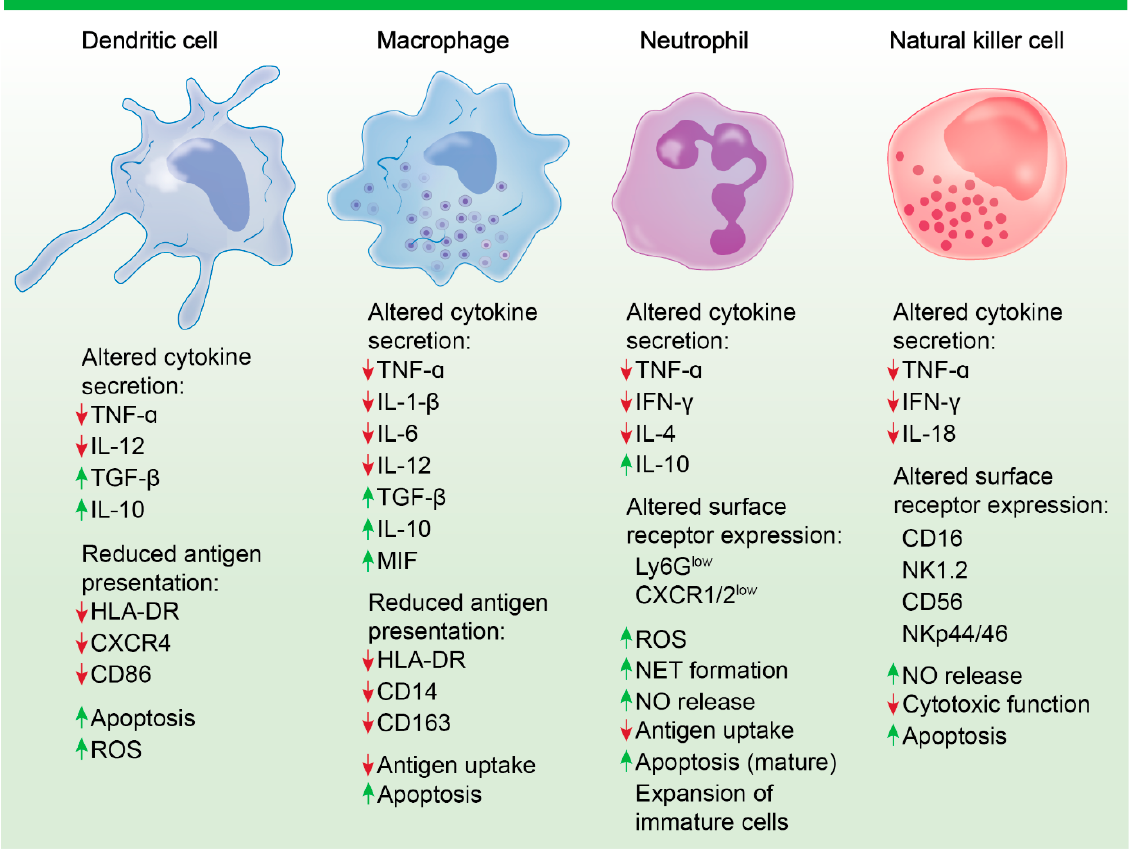
Figure 1. Sepsis-induced immune dysregulation and suppression of innate immune cells. Altered cytokine secretion and reduced antigen presentation is notable in sentinel dendritic and macrophage cells following sepsis in patients. Cytokines such as TNF- α are reduced and cytokines such as IL-10 are upregulated [73–77]. Altered cytokine secretion and surface receptor expression is notable in neutrophils and NK cells post-sepsis [78–80]. Marked apoptosis of most innate immune cells is evident [81]. Mature neutrophils undergo apoptosis during sepsis, however expansion of immature, damaging neutrophils occurs [7].